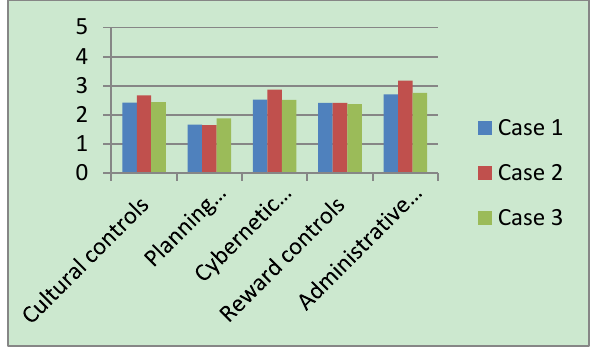
Figure 3. Amount of challenge for reflection—group level.